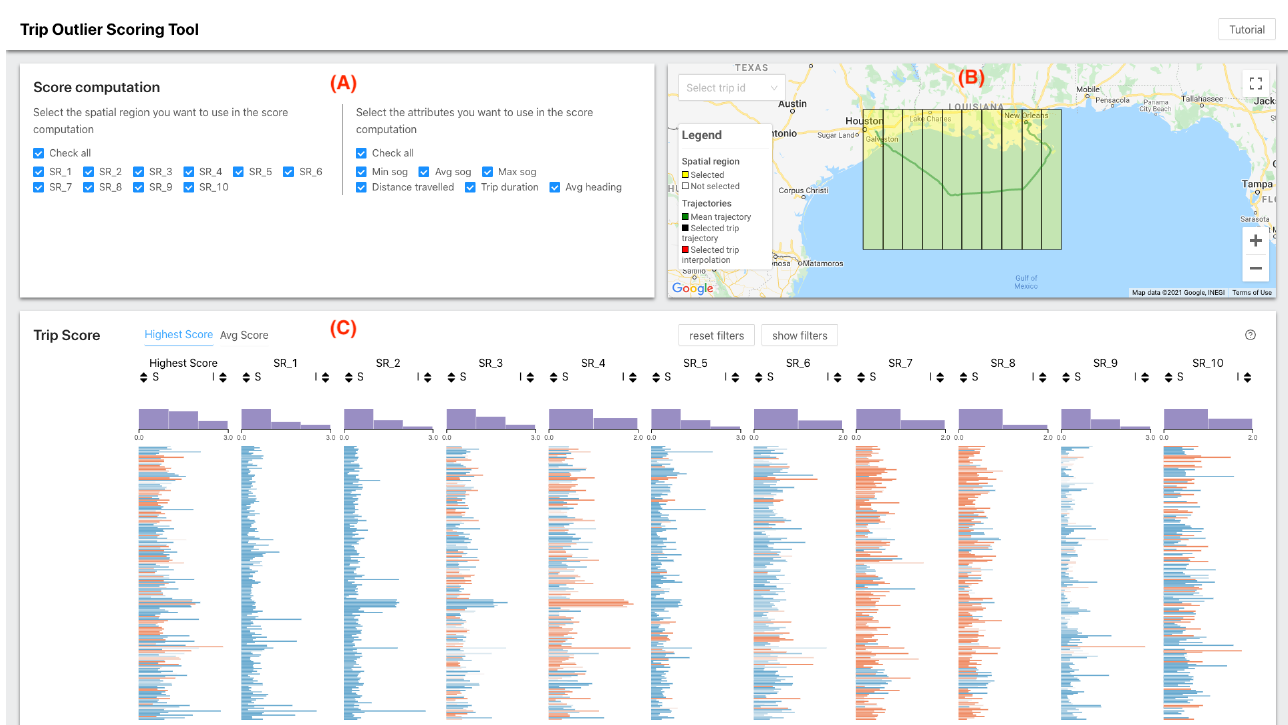
Figure 3. Overview of the Trajectory Outlier Scoring Tool (TOST). The user utilizes the score computation component ( A ) to control which spatial regions and attributes will be used in the score. The user can filter and sort the data and select a trip trajectory displayed in the map ( B ), and the trip scores are visualized in the trip score component ( C ).